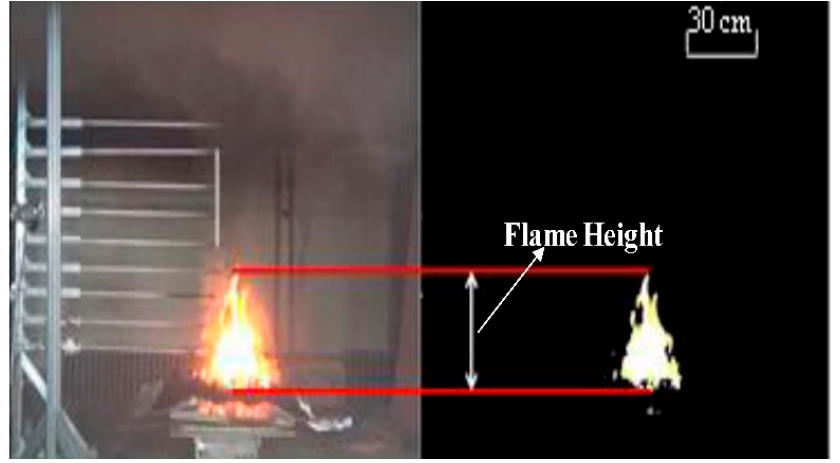
Figure 5. Comparison between pictures of fl ame height before and after processing.